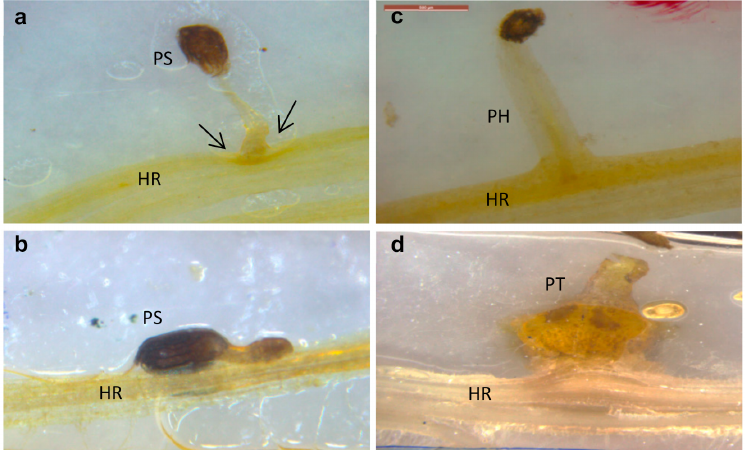
Figure 3. Resistant (‘EMEK3’) ( a , b ) and susceptible (‘D.Y.3’) ( c , d ) sunflower roots infested with O. cumana , 10 ( a , c ) and 21 ( b , d ) d post infestation. PH: parasite haustorium; HR: host root; PS: parasite seedling; PT: parasite tubercle.